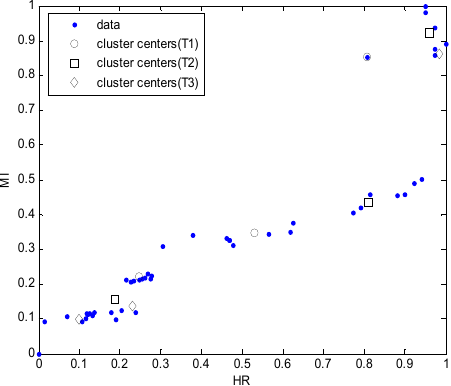
Figure 6. Estimation of cluster centers in each context (p = 3).